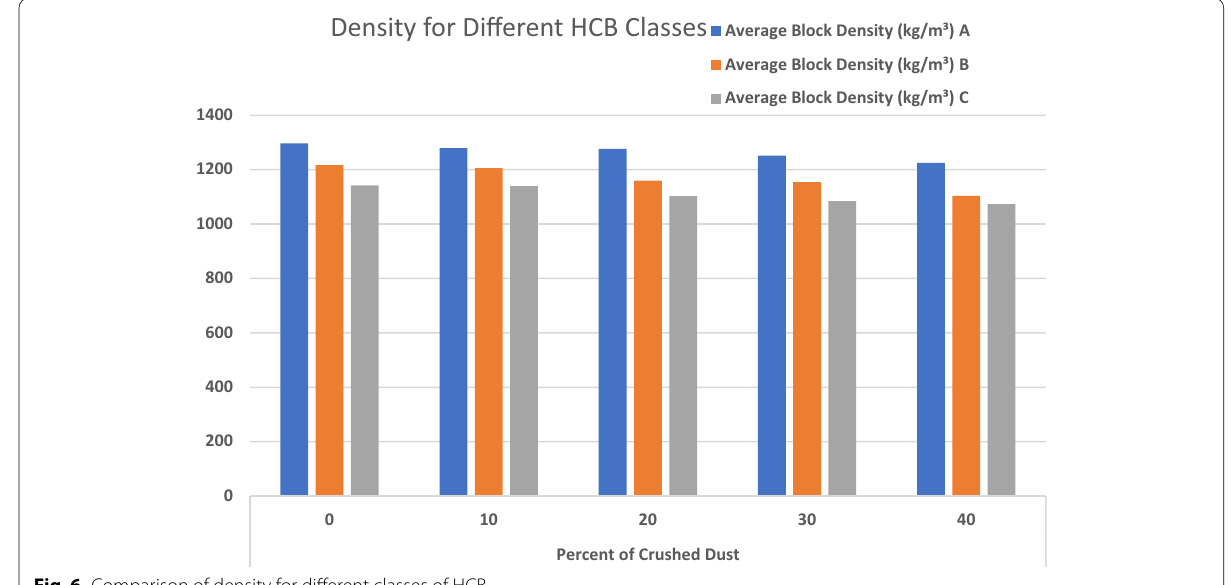
Fig. 6 Comparison of density for different classes of